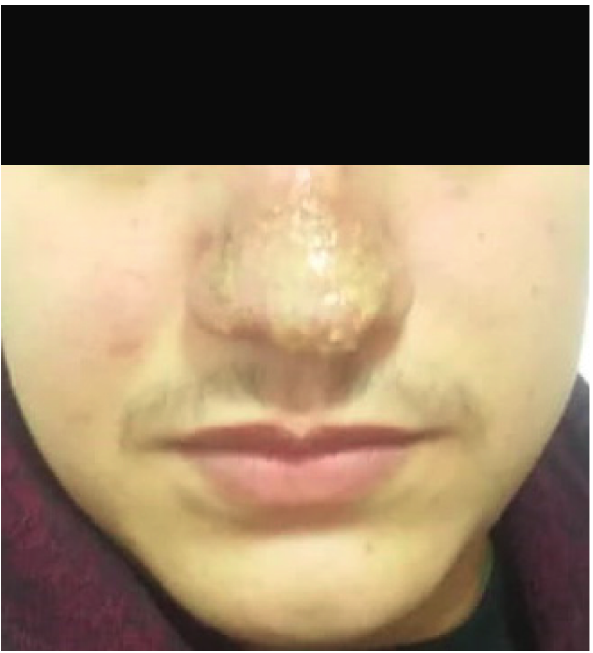
Figure 8: Response of the lesion to meglumine antimoniate treatment: stopping